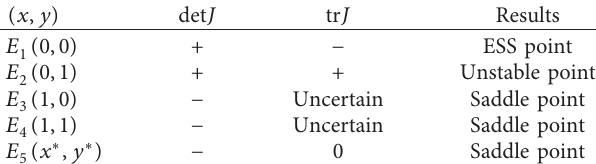
Table 6: The stability analysis of Model